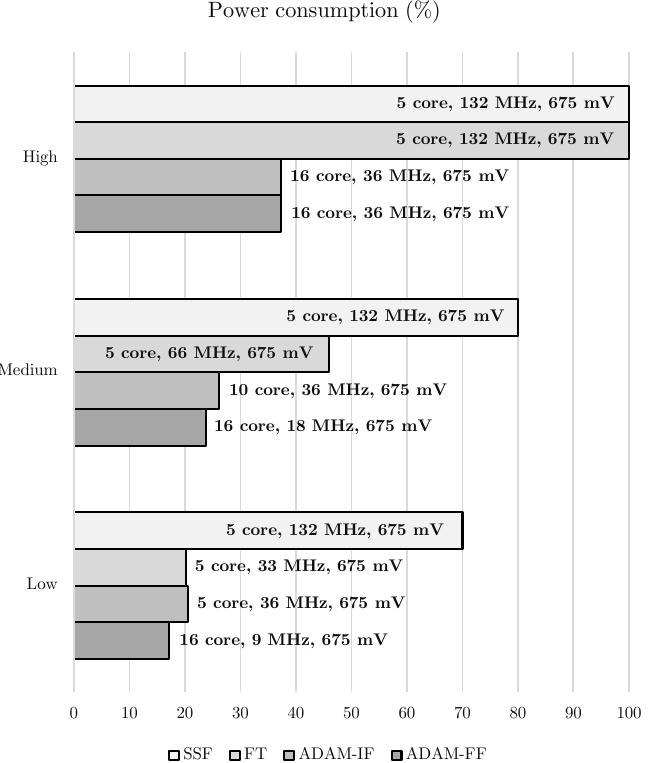
Figure 15. Comparison of power consumption in different ADAM configurations with high work- loads (processing of six ECG